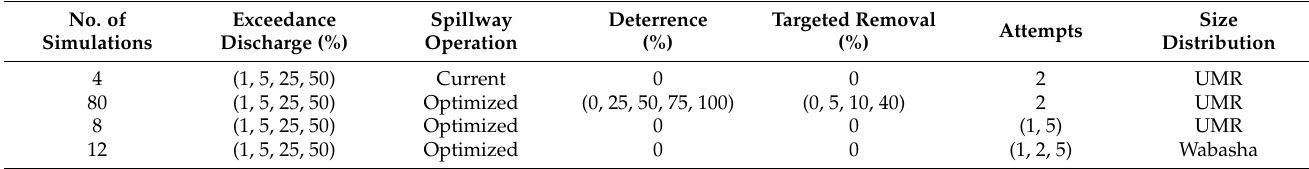
Table 4. List of unique model simulations. Brackets indicate range of values used in each simulation. Each simulation provides the annual proportion passing either a single or pair of two consecutive LDs.